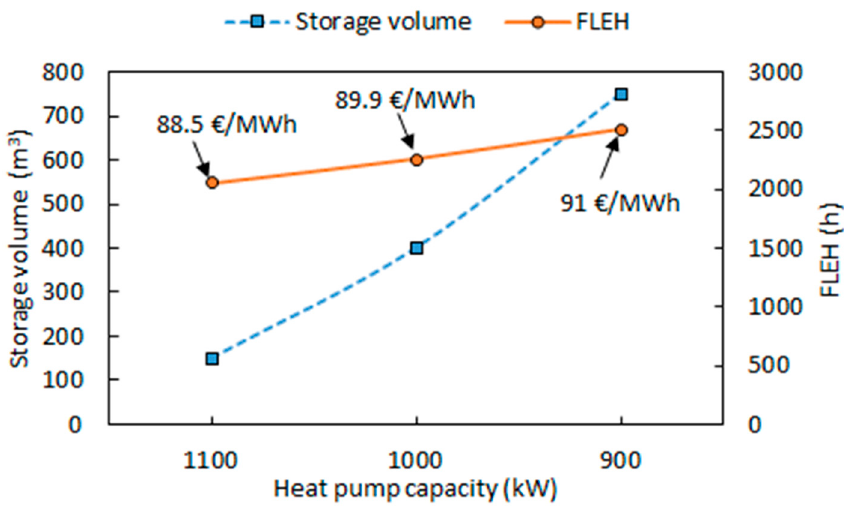
Figure 13. Effect of varying heat pump capacity on storage volume (left axis), FLEH (right axis) and LCOHC (data label).